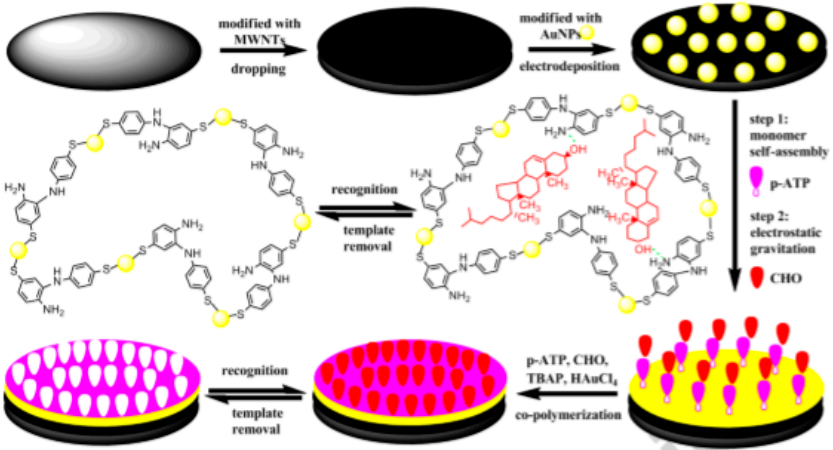
Figure 14. Schematic illustration of MIP/GCD/MWCNTs/AuNPs cholesterol biosensor. Reprinted with permission from Ref. [82].